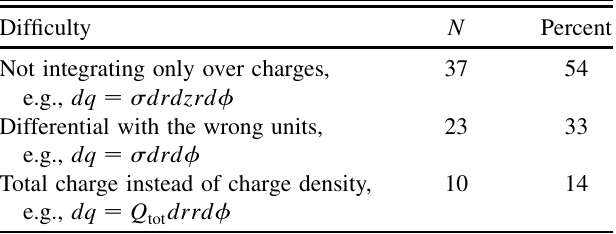
TABLE I. Difficulties expressing the differential charge ele- ment ( dq ). Percentages are of just the students who had difficulty with dq (42% of 166, N ¼ 69 ). Codes are not exhaustive or exclusive but represent the most common themes; thus, the total N in the table need not sum to